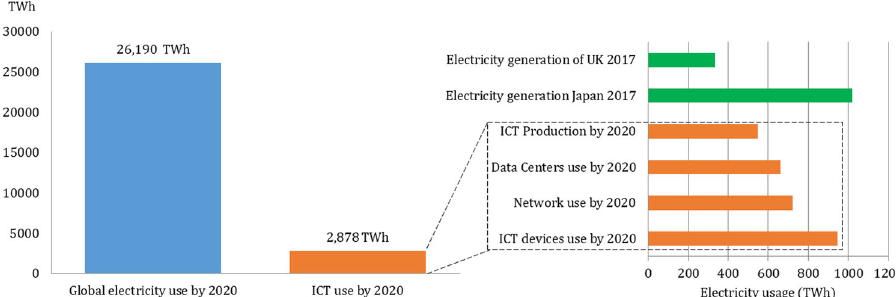
Fig. 1 Electricity consumption of the information and communication technology (ICT) sector. Expected consumption of electricity by 2020 of the ICT sector accounts for 11% of the Global use of electricity (data from ref. 5 ). For comparison, the electricity usage of Data Centres and Network exceeds the electricity generation of United Kingdom in 2017, and the ICT device usage is comparable to the electricity generation of Japan in 2017 (data from ref. 6 ).